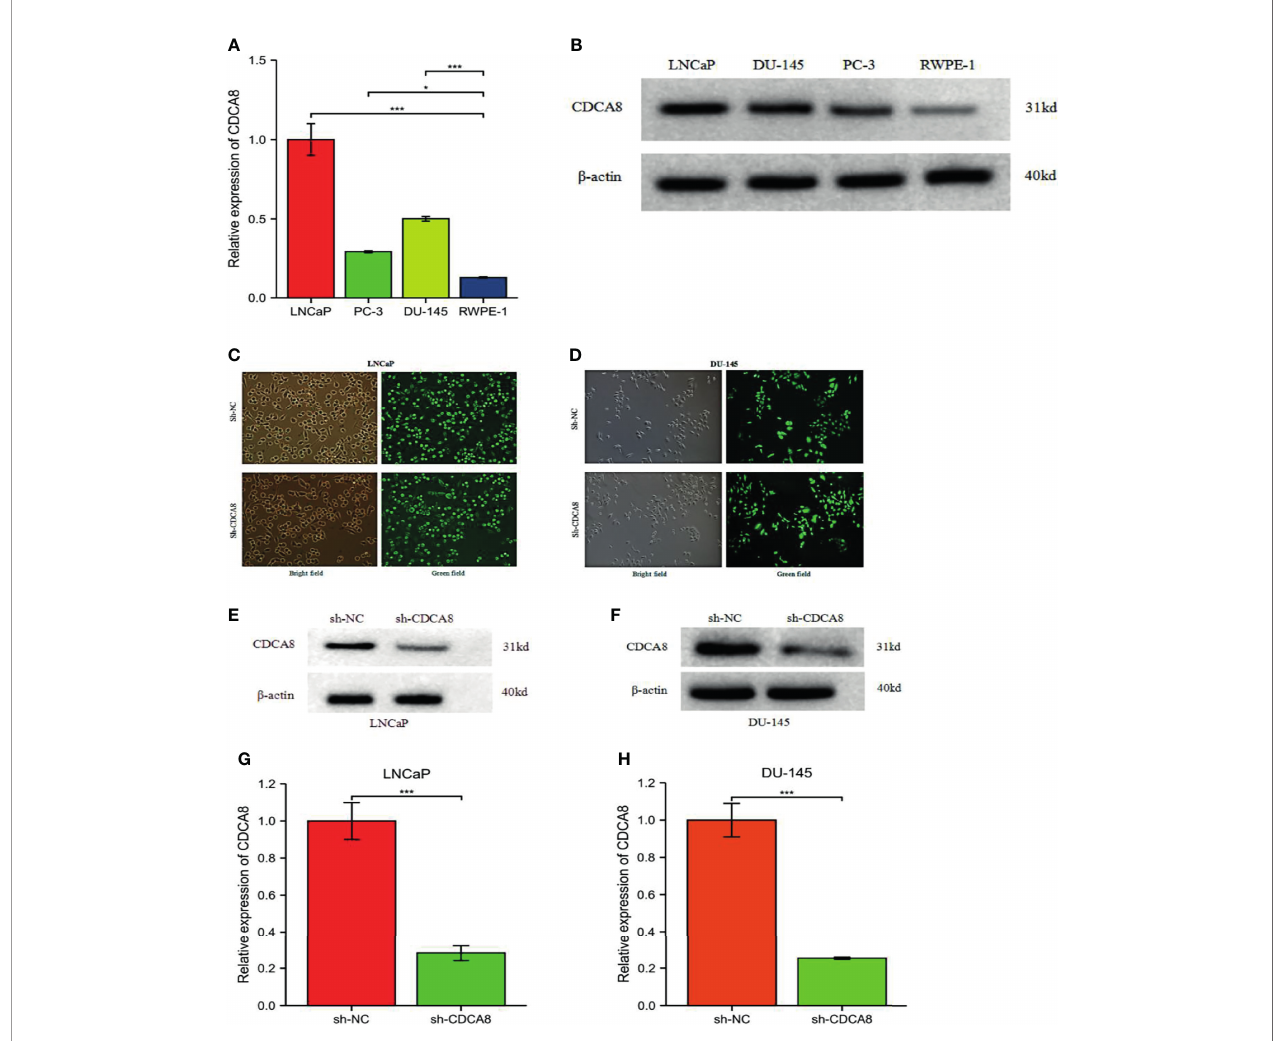
FIGURE 8 | The mRNA expression levels of CDCA8 in RWPE-1 and PCa cells. Sh-NC, negative control. CDCA8 expression levels were higher in PCa cells (A, B) . The knockdown ef fi ciency of LNCaP and DU-145 cells was observed by inverted fl uorescence microscopy (C, D) . After sh-CDCA8 and sh-NC were transfected into LNCaP and DU-145 cells, the expression levels of CDCA8 were detected by qRT-PCR and Western blotting (E-H) , *P < 0.5; ***P < 0.001; two-tailed